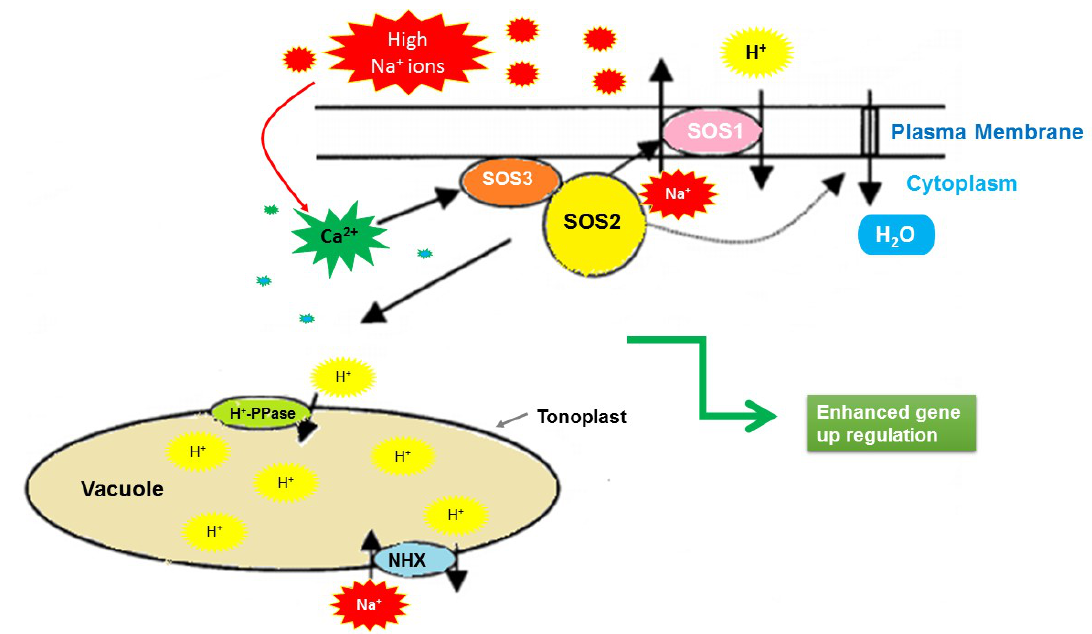
Figure 13. Regulation of Na + and K + ion homeostasis by the SOS pathway. Excess Na + ions elicit a calcium signaling pathway that activates the SOS1–SOS3 protein kinase complex, which stimulates the SOS1 and sodium proton antiporter ( NHX-2 ) exchange activity and, thus, regulates the expression of genes encoding them.